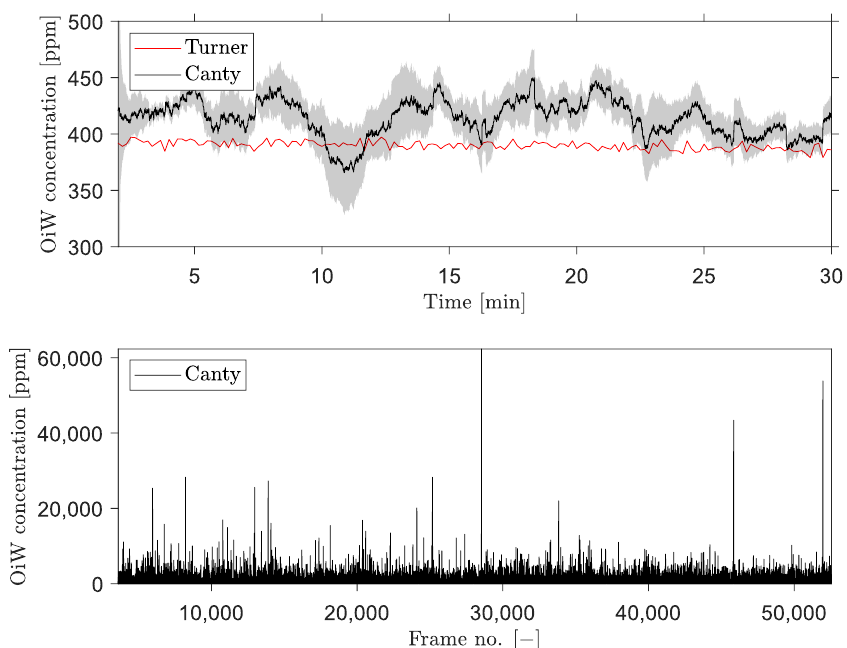
Figure 19. Same procedure as in Figure 17 for real-time OiW concentration measurement based on captured images from C 3 at another measurement range of ∼ 400